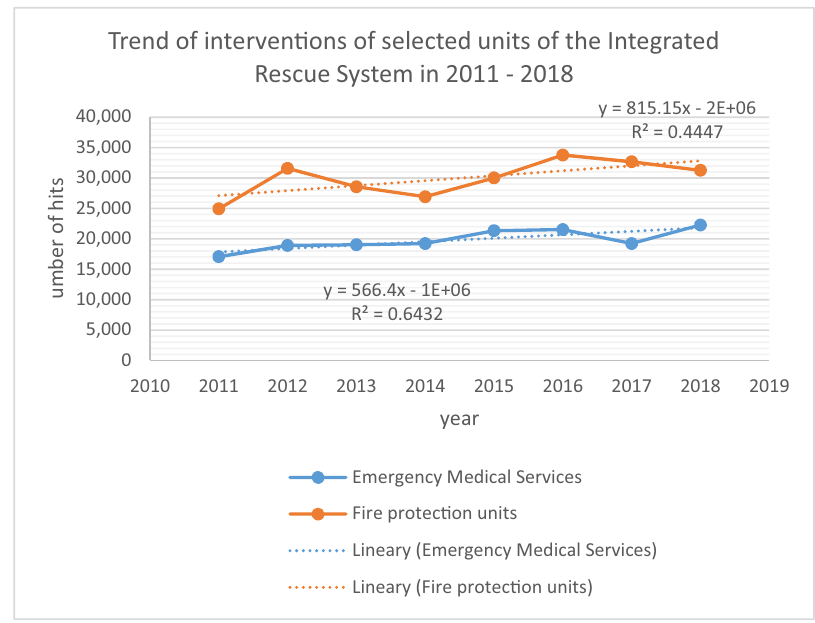
Figure 3: Integrated rescue system intervention development